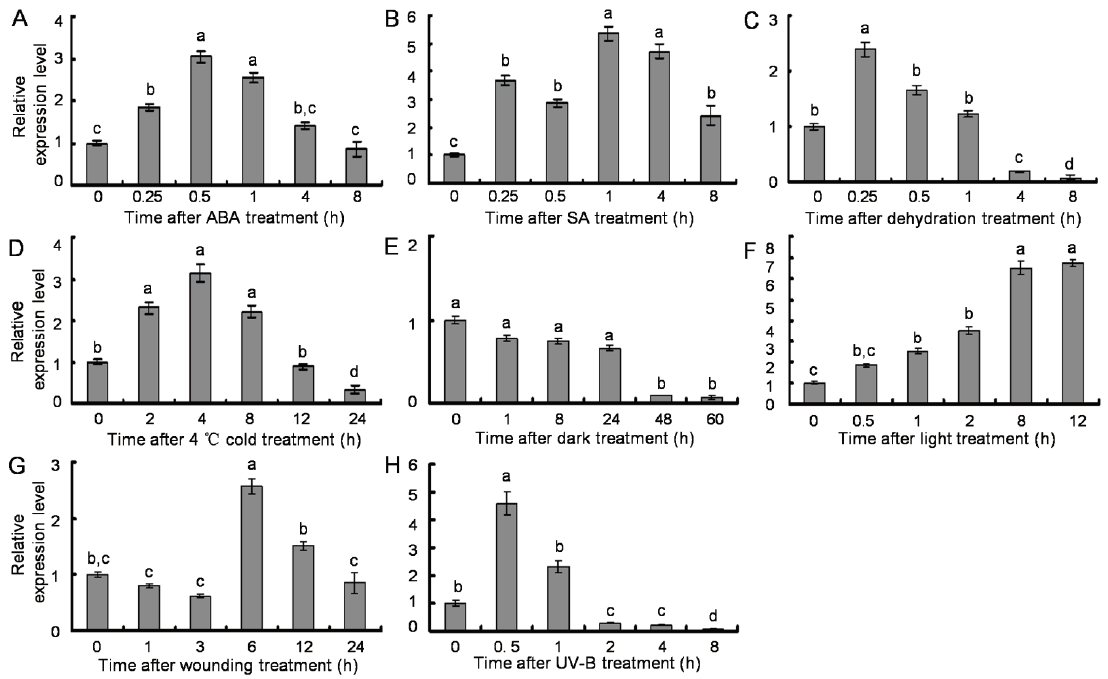
Figure 7. Transcription pattern of SsPAL1 under different treatments by qRT-PCR analysis. ( A ) 100 μ M ABA; ( B ) 500 μ M SA; ( C ) dehydration; ( D ) 4 °C cold; ( E ) dark; ( F ) 25 °C